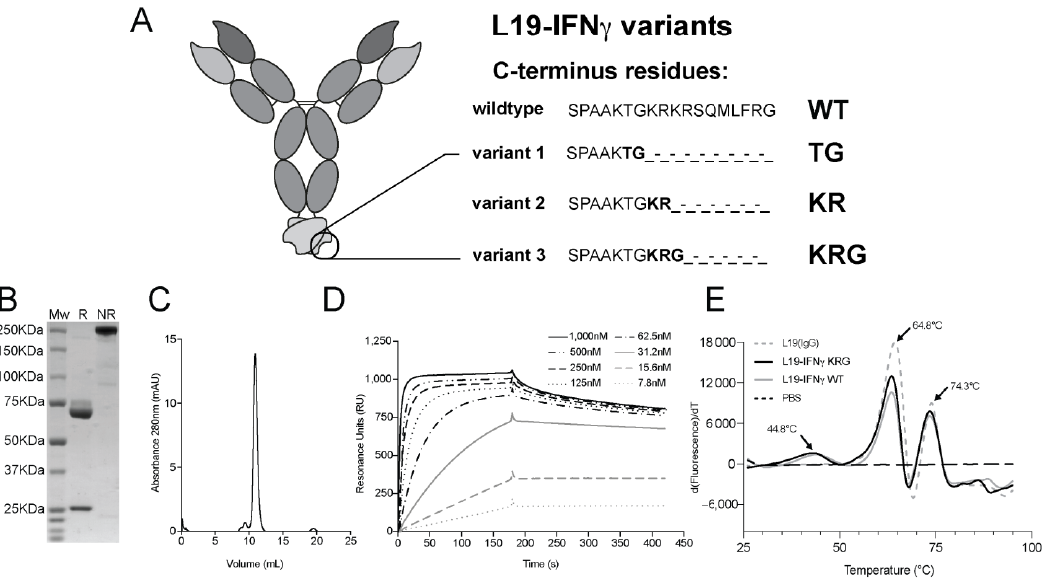
Figure 1. L19-IFN γ variants and biochemical characterization of fully human L19-IFN γ KRG. ( A ) Schematic representation of L19-IFN γ variants and relative C-terminus residues according to truncation. ( B ) SDS-Page analysis on 10% gel in reducing (R) and non-reducing conditions (NR) of L19-IFN γ -KRG. ( C ) Size exclusion chromatogram of L19-IFN γ KRG. ( D ) SPR of L19-IFN γ -KRG on EDB-coated CM5 sensor chip. ( E ) Differential scanning fluorimetry of L19 IgG, L19-IFN γ KRG and L19-IFN γ WT.